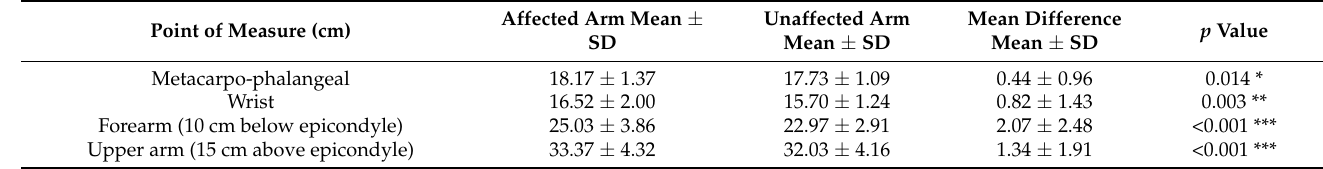
Table 6. Comparison of arm circumference measurement between affected and unaffected arms of women in lymphedema group ( n =